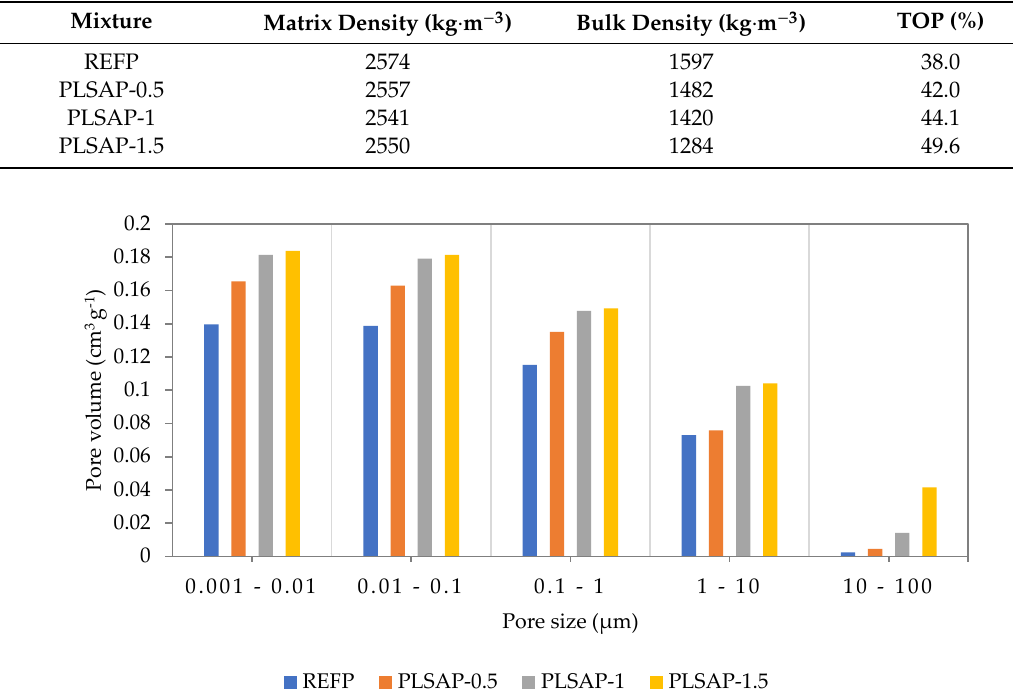
Table 2. Basic material properties of studied plasters.